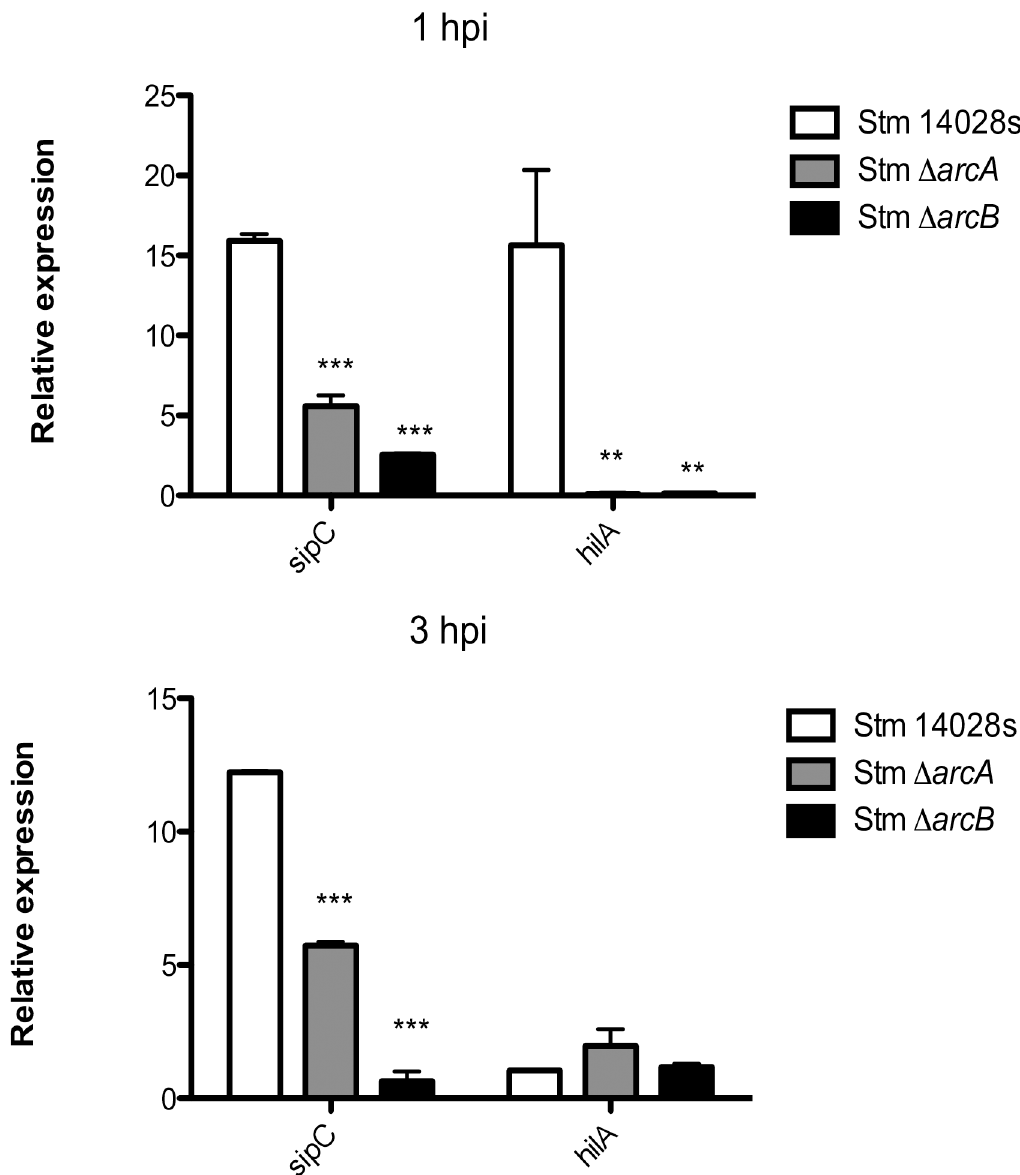
Fig 3. Relative expression of SPI-1 genes sipC and hilA in S . Typhimurium Δ arcA and Δ arcB strains inside bone-marrow- derived murine neutrophils. The effect of Δ arcA and Δ arcB on SPI-1 genes sipC and hilA was determined from bacteria isolated from infected bone-marrow-derived murine neutrophils. (cid:3) P < 0.05; (cid:3)(cid:3) P < 0.01; (cid:3)(cid:3)(cid:3) P < 0.001. One-way ANOVA with the Bonferroni correction comparing mutant strains with a wild type strain separately at 1 and 3 h postinfection. Biological replicates n = 5, three technical replicates per